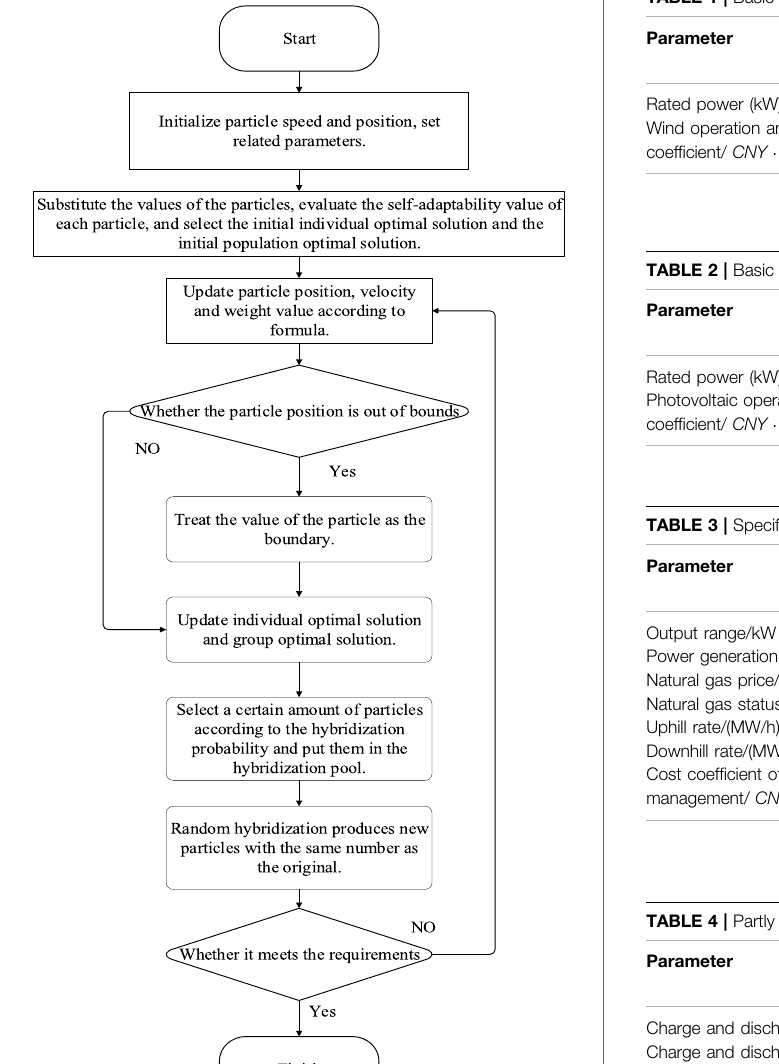
TABLE 1 | Basic parameters of the fan.